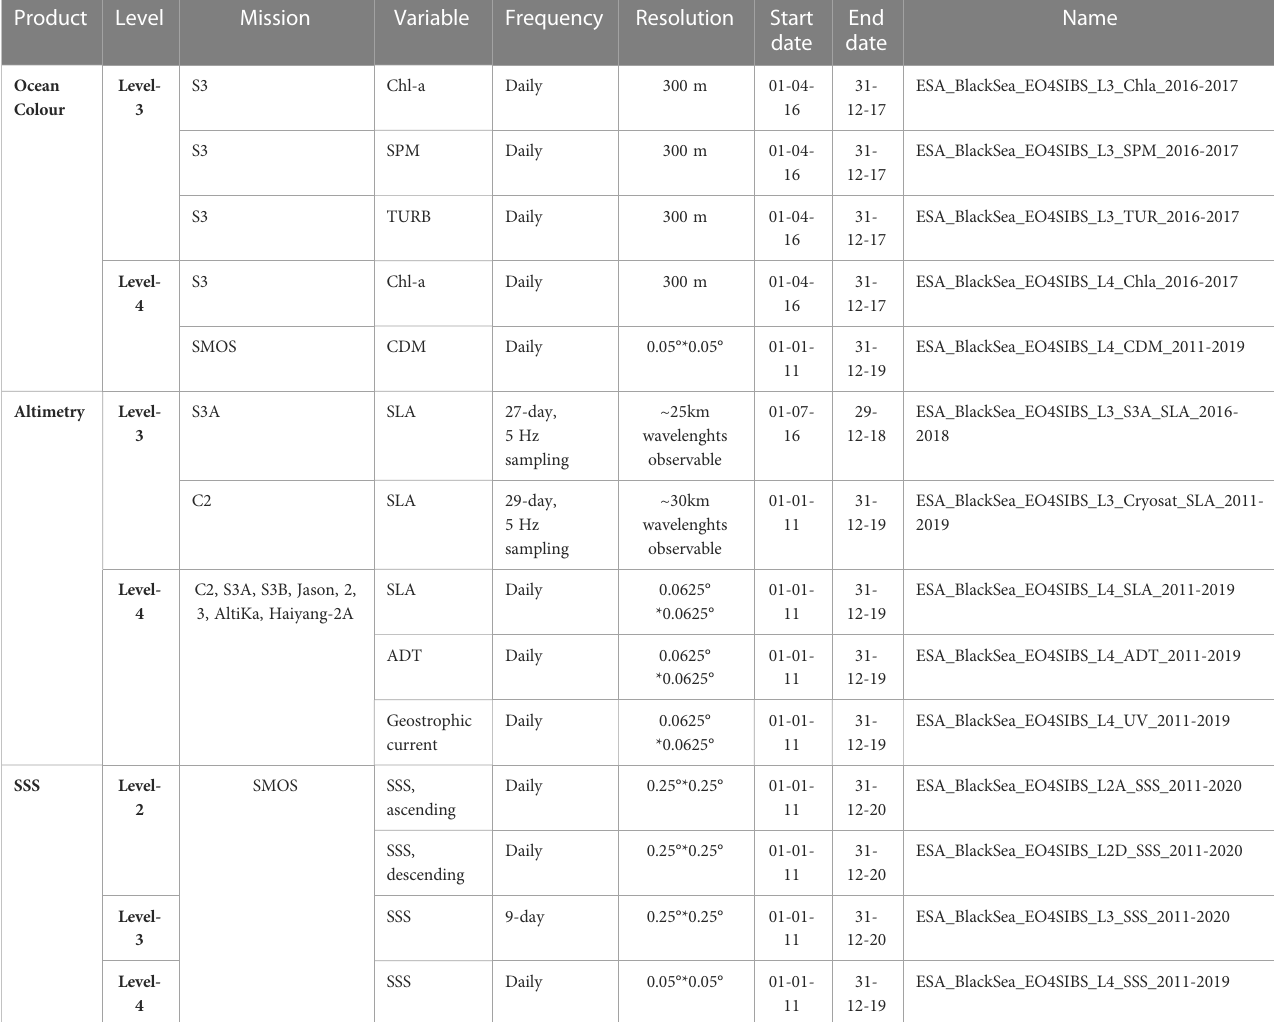
TABLE 1 List of products and their characteristics presented in this paper.